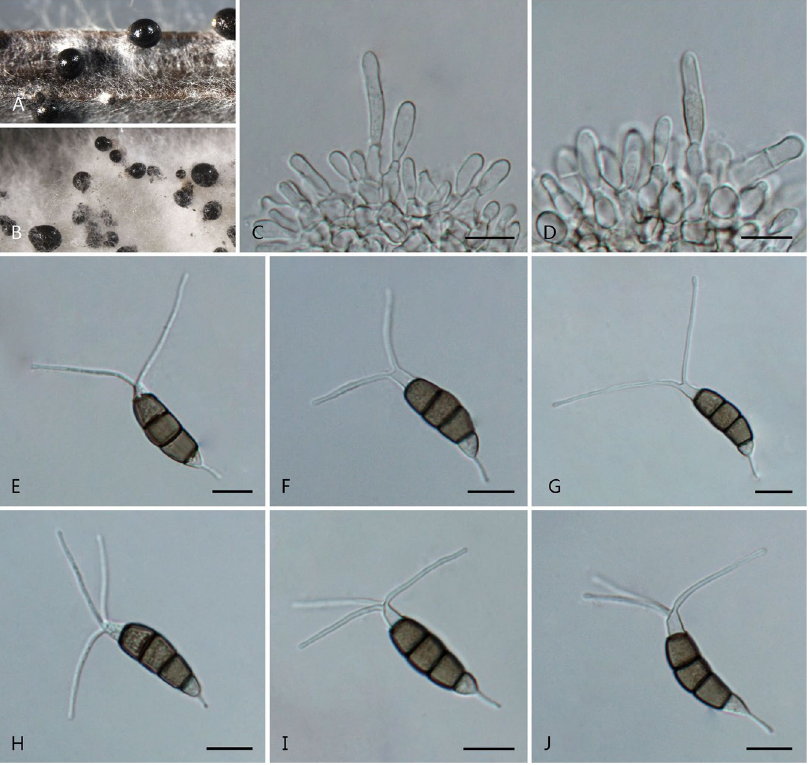
Figure 14. Pseudopestalotiopsis ampullacea (from ex-holotype culture CGMCC 3.18157 ( = LC6618)). ( A ) Conidiomata sporulating on pine needles; ( B ) Conidiomata on PDA. ( C–D ) Conidiogenous cells and conidia. ( E–J ) Conidia. Scale bars = 10 μ